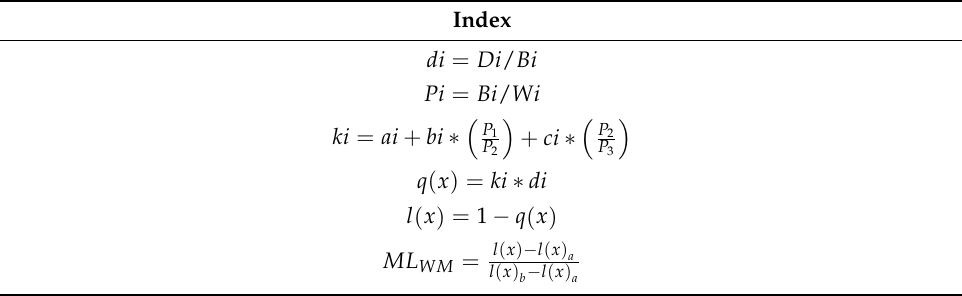
Table 1. Formulae for derived